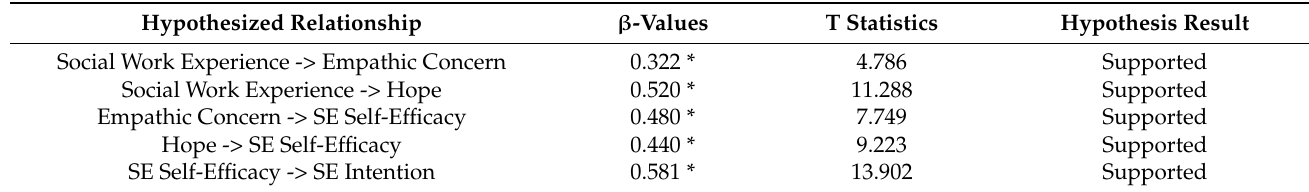
Figure 2. Structural model results. Table 6. Hypothesis results and path